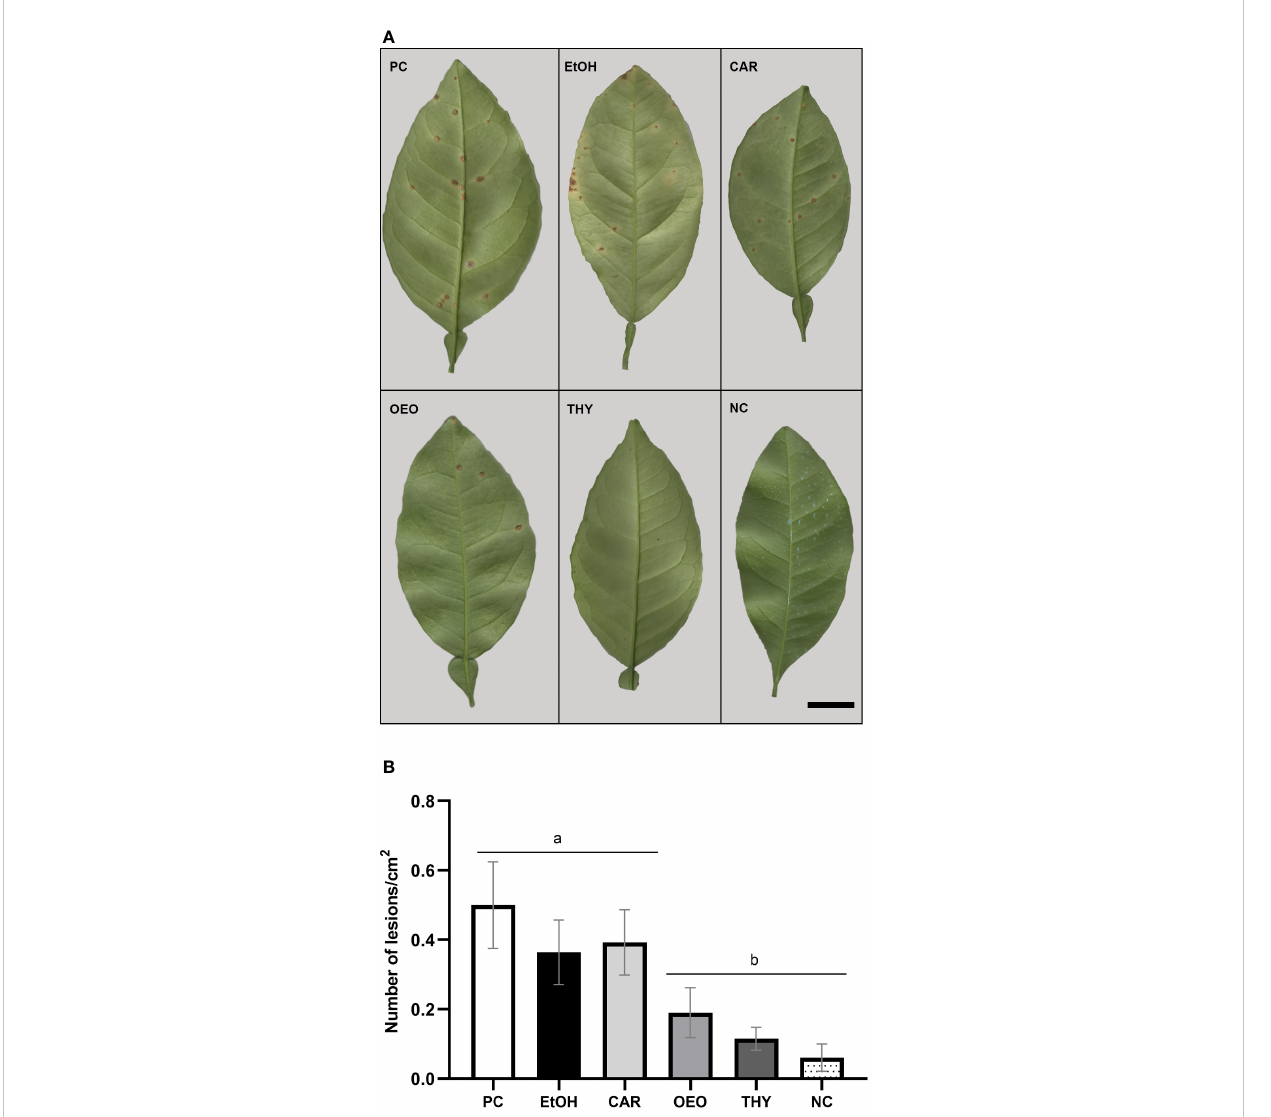
FIGURE 5 OEO and THY protected citrus nursery trees against X. citri infection. Nursery trees of Citrus sinensis cv. Pera were spray-treated with the compounds at their bactericidal concentrations and after, challenged with the bacterium. Leaves were detached after 45 days for documentation and analyses. (A) Representative leaves with canker lesions for each treatment. Positive control (PC) for infection, sprayed with PBS 1X; Carvacrol (CAR), oregano essential oil (OEO) and thymol (THY) treatments. Nursery trees in the negative control for infection were sprayed with the commercial formulation Difere at 20 µL.mL -1 (NC). Vehicle control (EtOH), 1% ethanol. Scale (black bar): 1 cm. (B) Canker lesion per foliar arear. Bars represent the average number of lesions/cm 2 and whiskers the 95% con fi dence interval. Different letters (a and b) show the statistical difference between treatments ( P